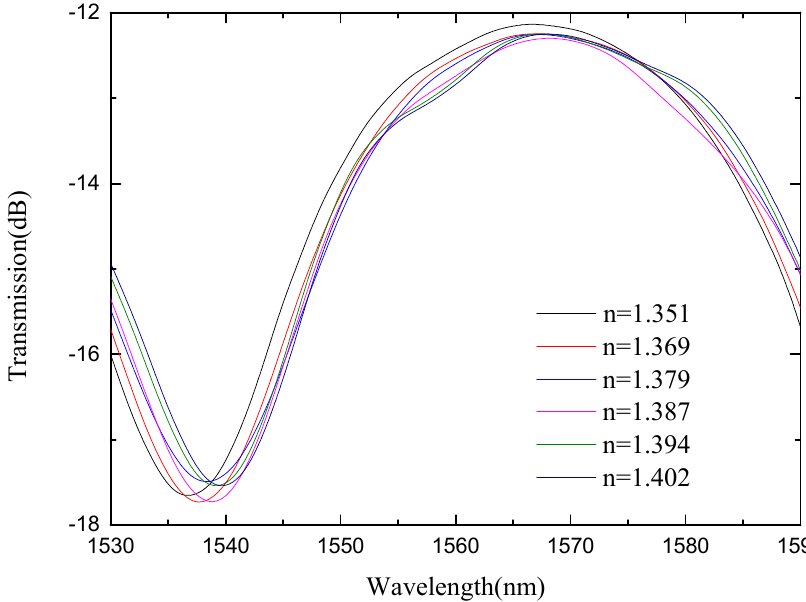
Figure 12. Spectra of SMS MZI at different refractive indices.